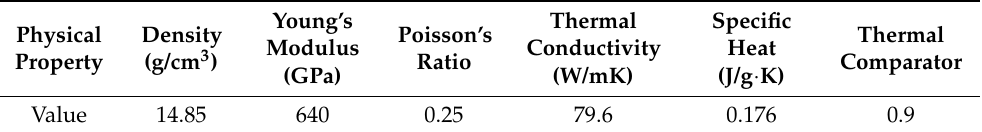
Table 1. Physical properties of YG6 cutting